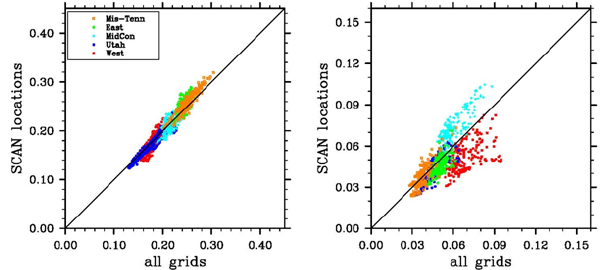
Fig. 6. Scatter plot of Noah daily mean soil moisture (cm 3 cm − 3 , left panel) and standard deviation (right panel) calculated at SCAN locations versus those over all grid points in each region.